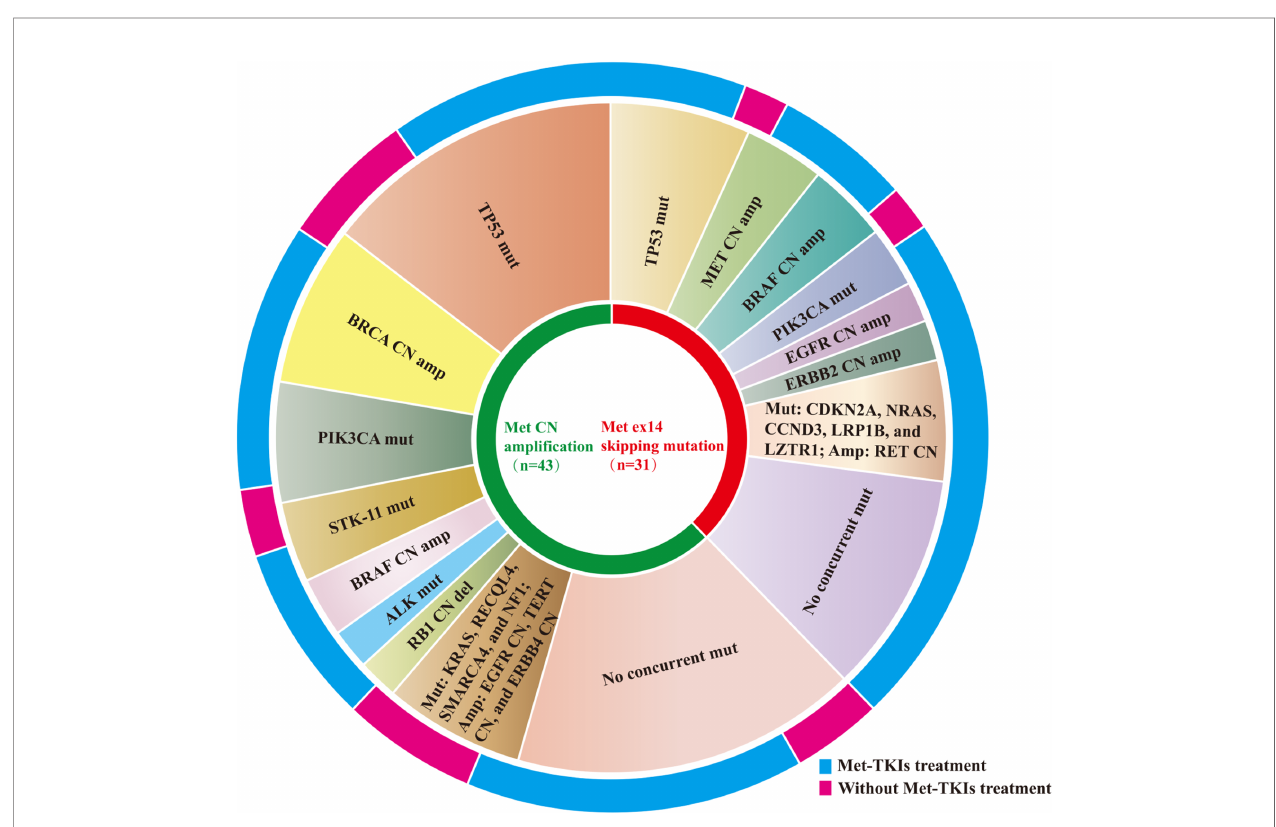
FIGURE 2 | Distribution of concurrent mutation detected in MET ampli fi cation and METex14 skipping mutation